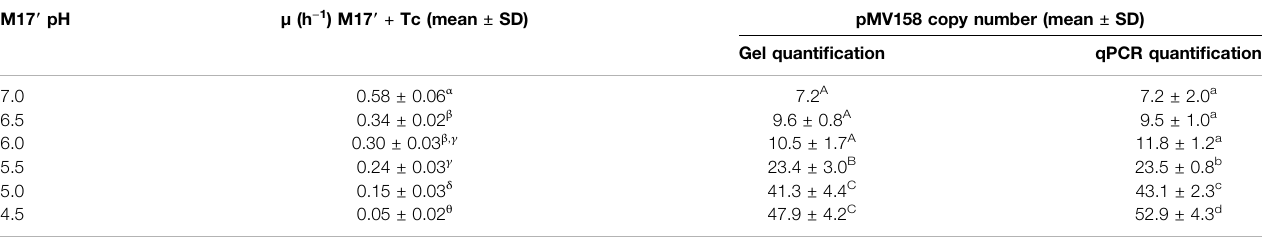
The number of pMV158 plasmid molecules per chromosome equivalent was determined by qPCR or by densitometric analysis of agarose gels. In this latter method, the plasmidic to chromosomalDNA ratios were compared with that obtained in the lactococcal host cells grownat pH 7.0 in the presence ofTc, to which the corresponding qPCR-determined pMV158 PCN value (red color number) was assigned. The copy number and growth rate values given in the table are expressed as mean ± standard deviation of three independent experiments (biological samples). All the values with the same superscript letter were not found to have statistically signi fi cant